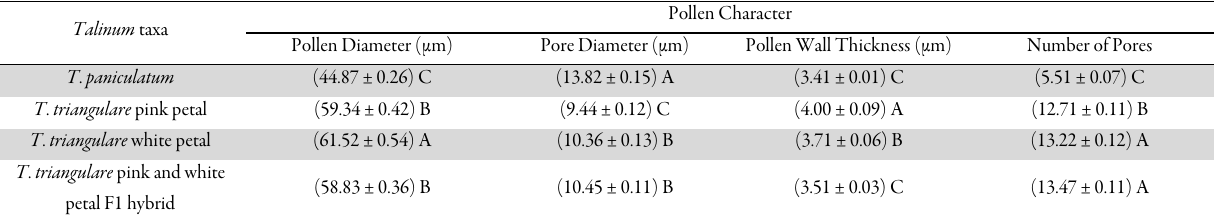
Table 1. Summary of quantitative characteristics and the Duncan grouping of the four taxa of Talinum studied based on their pollen grain attributes Talinum taxa